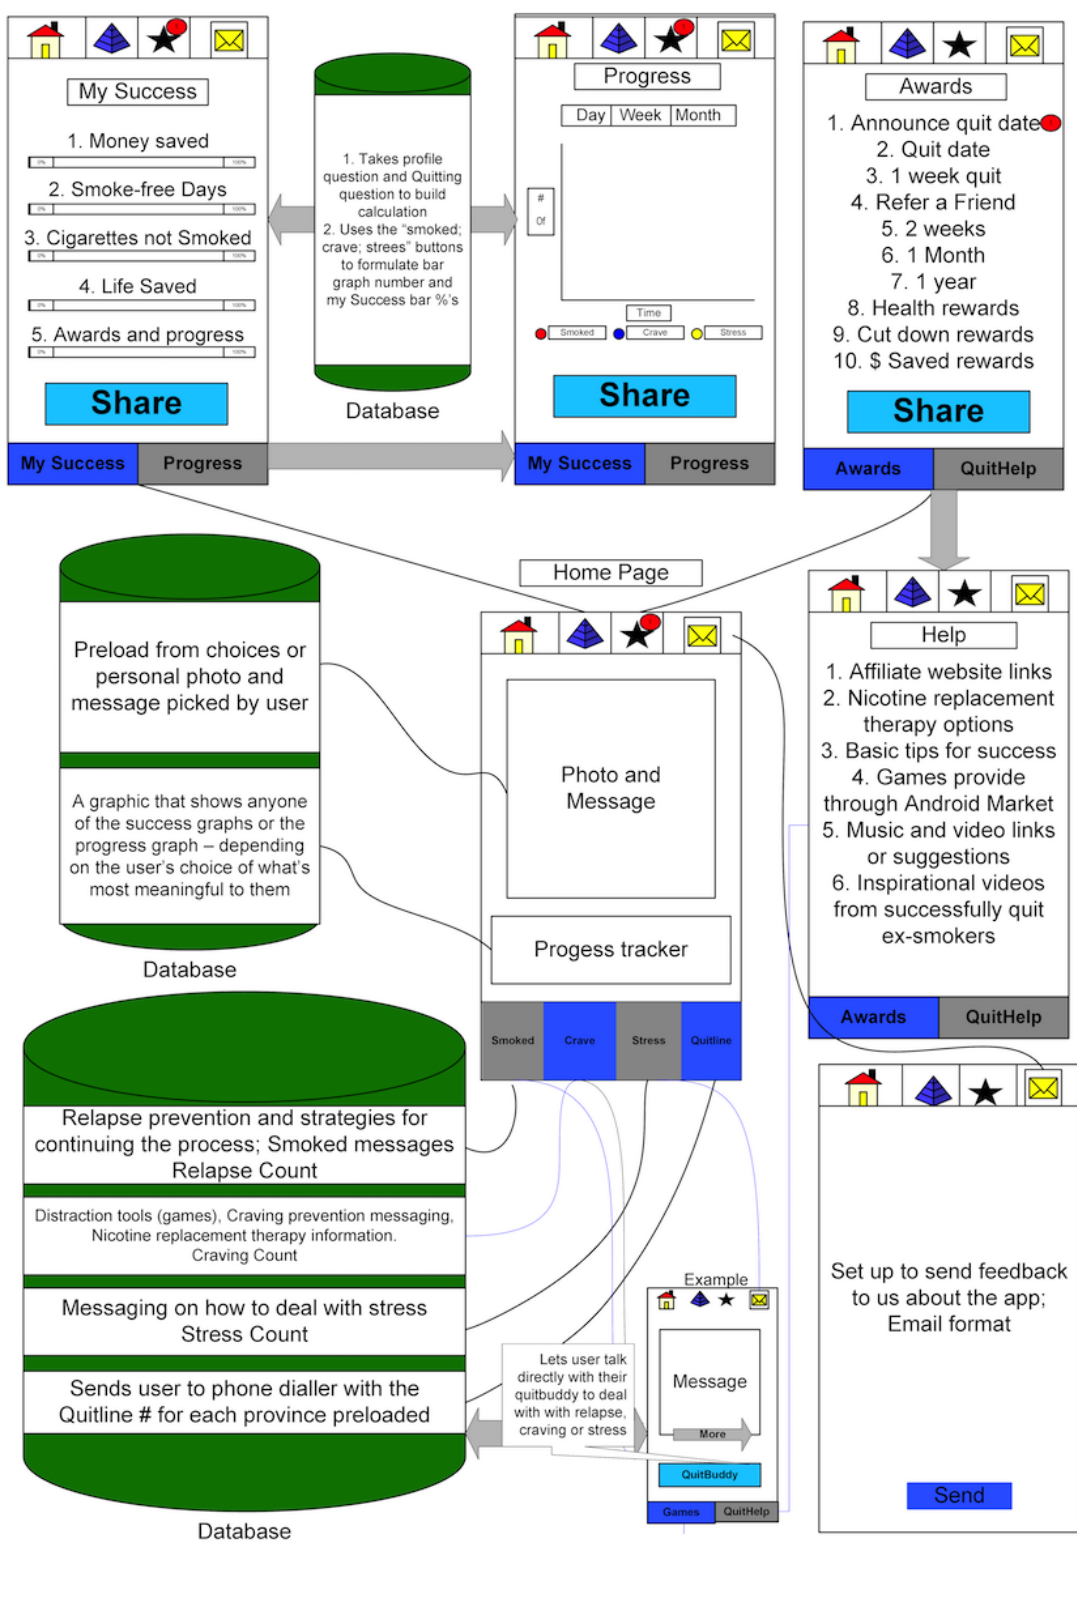
Figure 1. Phase II—example of storyboarding session